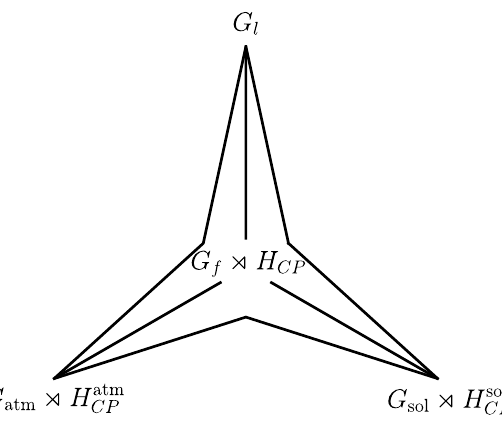
Figure 1 . A sketch of the tri-direct CP approach for two right-handed neutrino models, where the high energy family and CP symmetry G f o H CP is spontaneously broken down to G atm o H atm sector of one of the right-handed neutrinos, and G sol o H sol neutrino, with the charged lepton sector having a di(cid:11)erent residual (cid:13)avour symmetry G l